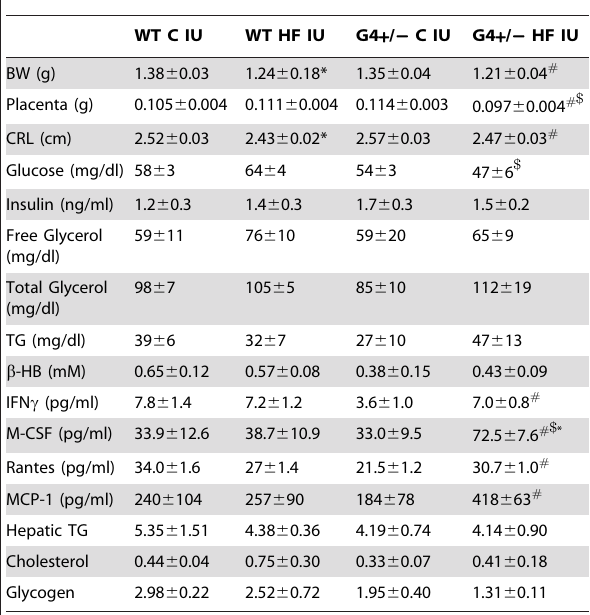
WT and G4 + / 2 fetuses at embryonic day 18.5 exposed to C or HF IU diet, n=5– 12/genotype/diet; *p , 0.05 vs. WT C; # p , 0.05 vs. G4 + / 2 C; $ p , 0.05 vs. WT HF IU. Hepatic triglyceride, cholesterol and glycogen content in m g/mg tissue. doi:10.1371/journal.pone.0063021.t002 Gene expression of forkhead transcription factor A2 (FOXA2), glycogen synthase kinase-3 alpha (GSK3 a ), and insulin like growth factor binding protein-1 (IGFBP-1), proteins whose activities are all regulated by insulin, were increased with HF IU compared to C IU liver (Table 3).